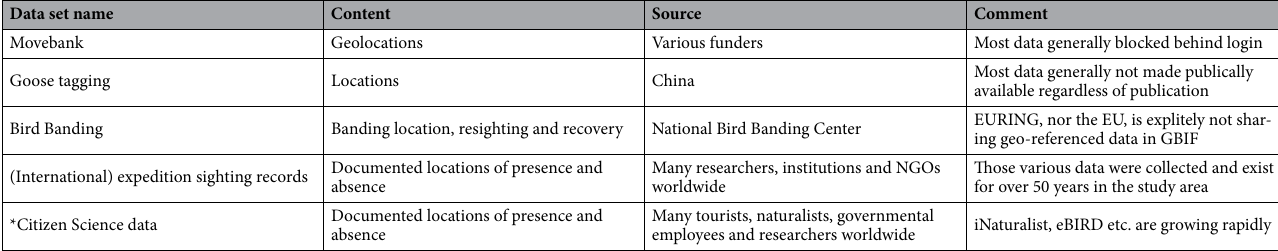
Table 3. Data known to be available for the study area and of great use for this work but not publically made available or useable (Note: Best professional practices, the International Polar Year, Migrator Bird Treaties, and most national funding schemes make Open Access data sharing mandatory; see 19 for a reality assessment and as found here). *Data are readily available but show little coverage and information for the study area,